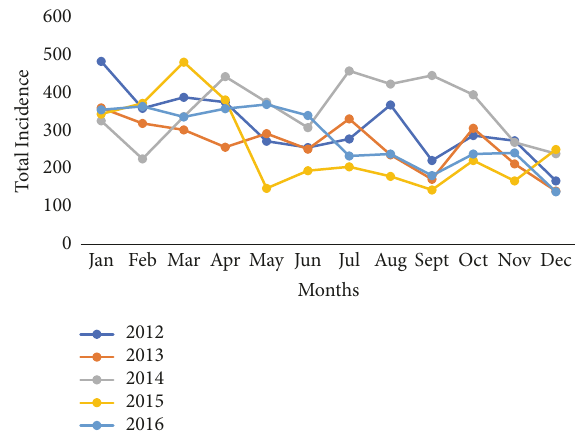
Figure 2: Yearly monthly patterns of diarrhea incidence in Jasikan District from 2012 to